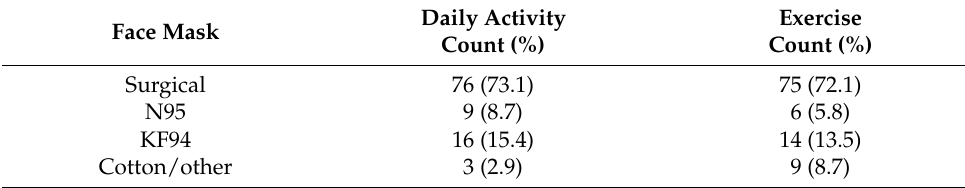
Table 2. Types of face masks used by participants during daily activity and exercise.